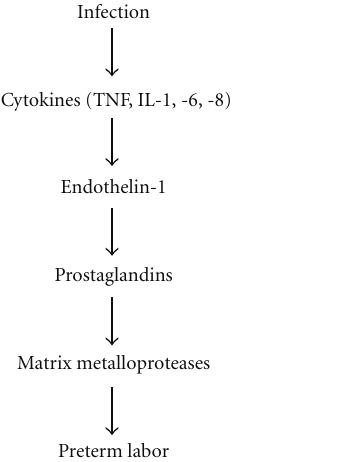
Figure 3: Parturition cascade with putative sites of action of endothelin-1 and matrix